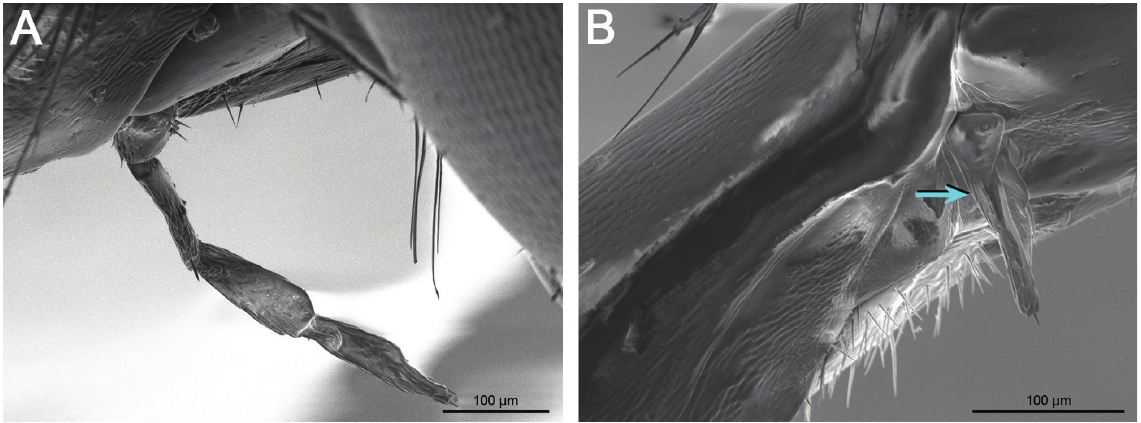
Fig. 12. SEM images of maxillary palpus, lateral view, of male. A . Brachymelecta californica (Cresson, 1878) (BOLD sample ID: CCDB-34570 A05; PCYU), which distinctly has four palpomeres. B . B. haitensis (Michener, 1948) (BOLD sample ID: CMNTO_037; JAG), which has no